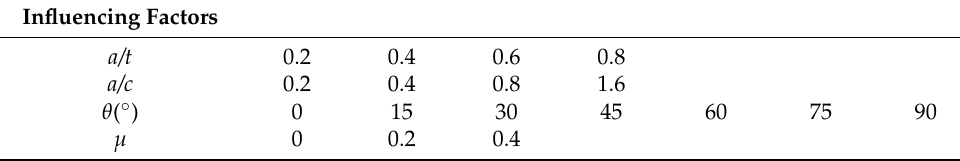
Table 2. Finite element calculation scheme.